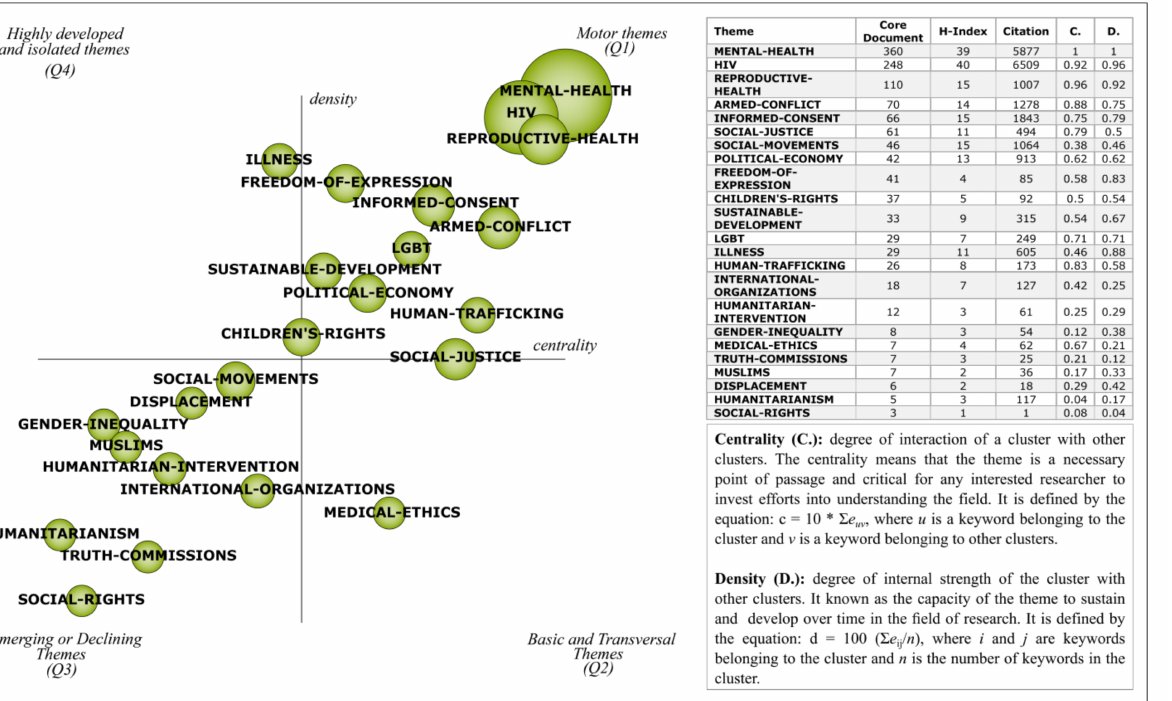
Figure 3. Strategic diagram depicting the performance of human